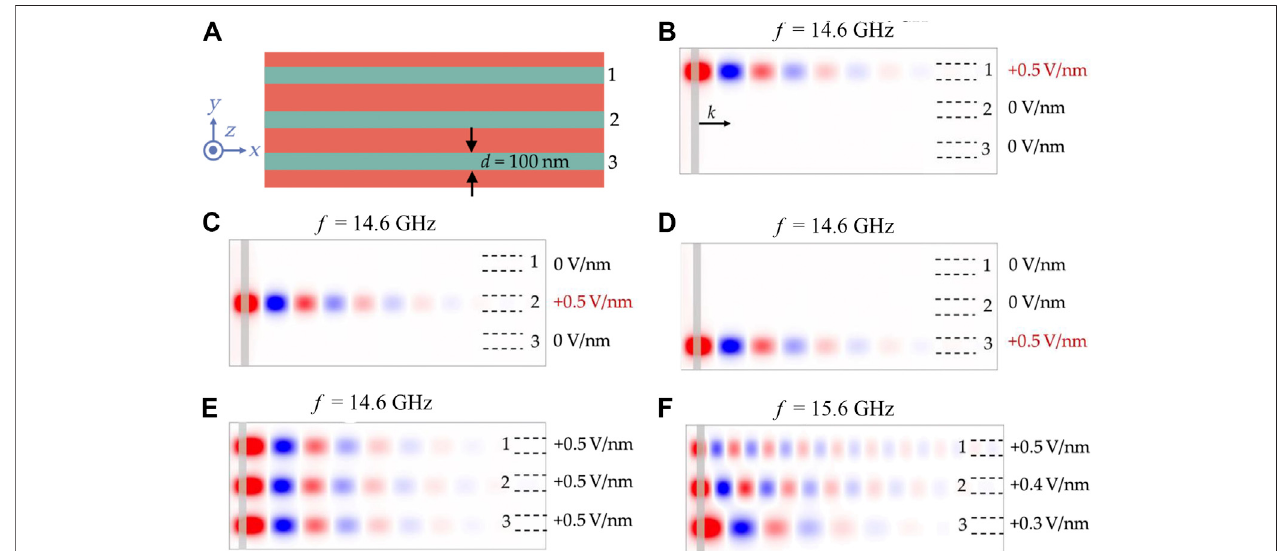
FIGURE 4 | (A) Top view of the waveguide (Rana and Otani, 2018). Due to VCMA, three spin-wave channels with a width of 100 nm are formed by three separate metalelectrodes. (B – F) Spatial distribution diagramofdynamicmagnetization. (B) Avoltageisapplied totheupperelectrodetoformaspinwave-channel; (C) Avoltage isappliedtothemiddleelectrodetoformaspin-wavechannel; (D) Avoltageisappliedtothelowerelectrodetoformaspin-wavechannel; (E) Threespin-wavechannels can be opened simultaneously; (F) Different phase accumulation occurs, where spin waves with different wave vectors pass through the waveguide. (A – F) Reproduced with the permission from https://journals.aps.org/prapplied/abstract/10.1103/PhysRevApplied.9.014033.